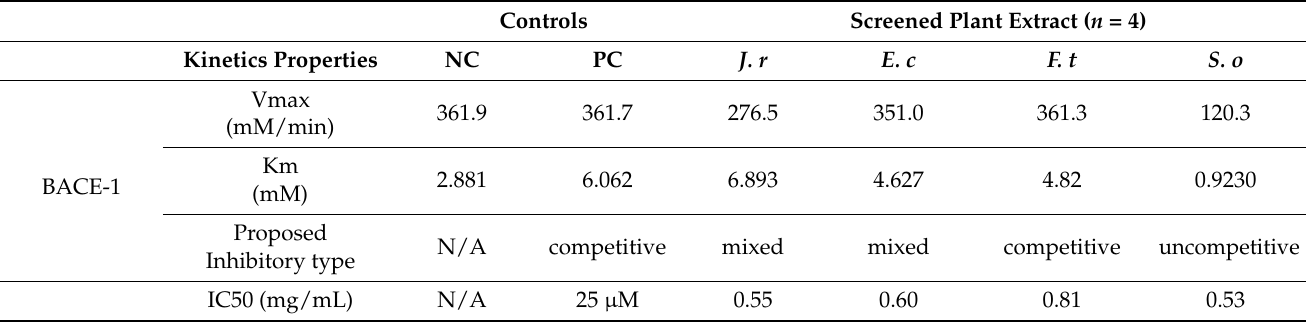
Table 2. BACE-1 inhibitory property of selected plant extracts ( n =